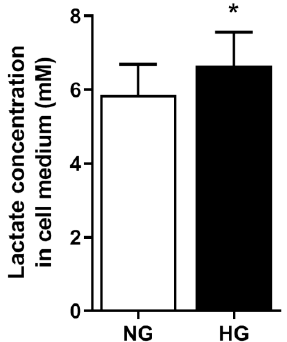
Figure 6. Concentration of lactate in cell media. Myotubes were treated with 20 mM glucose (HG) or 5 mM glucose (NG) for four days. Thereafter, the media was removed and lactate concentration measured using Accutrend Plus. Results are presented as means ± SEM in mM lactate from five individual experiments (n = 5). *Statistically significant vs. NG ( p < 0.05, paired Student’s t -test).